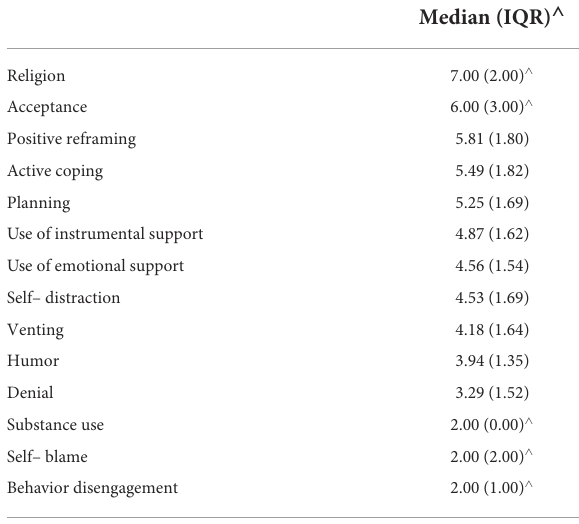
TABLE 4 The mean and standard deviation (SD) or the median and interquartile range (IQR) for each type of coping strategy utilized by the participants as reported in Brief–COPE ( N =